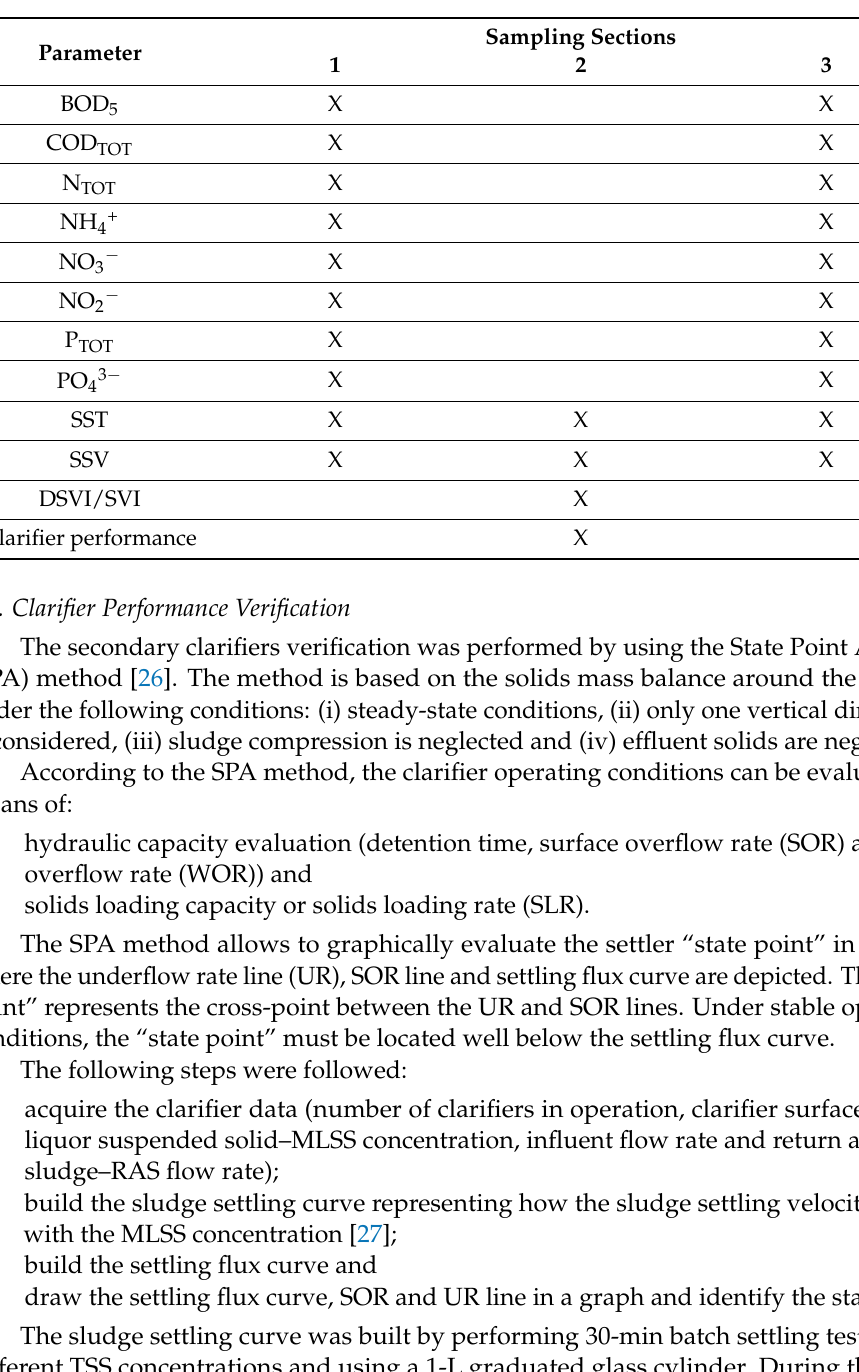
Table 2. List of parameters analyzed in each sampling section for both